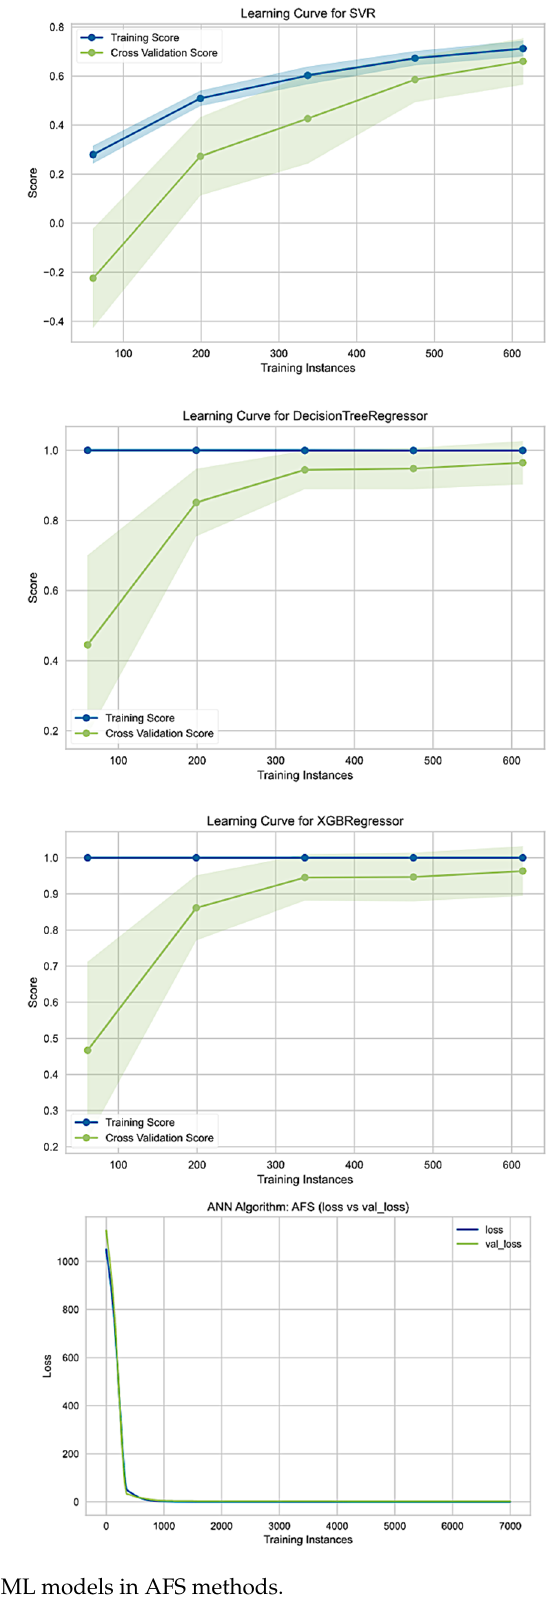
Figure 9. Learning curve of different ML models in AFS methods.